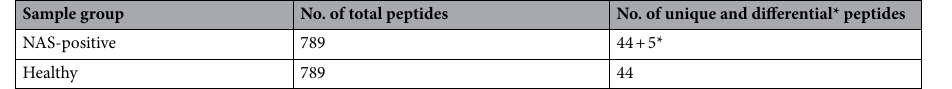
Table 2. Total and unique peptides identified in the two sample groups by LC–MS/MS and differential analysis. Complete data are reported in Supplementary Table 2. *Increased in the sample group based on the Welch t test with FDR ≤